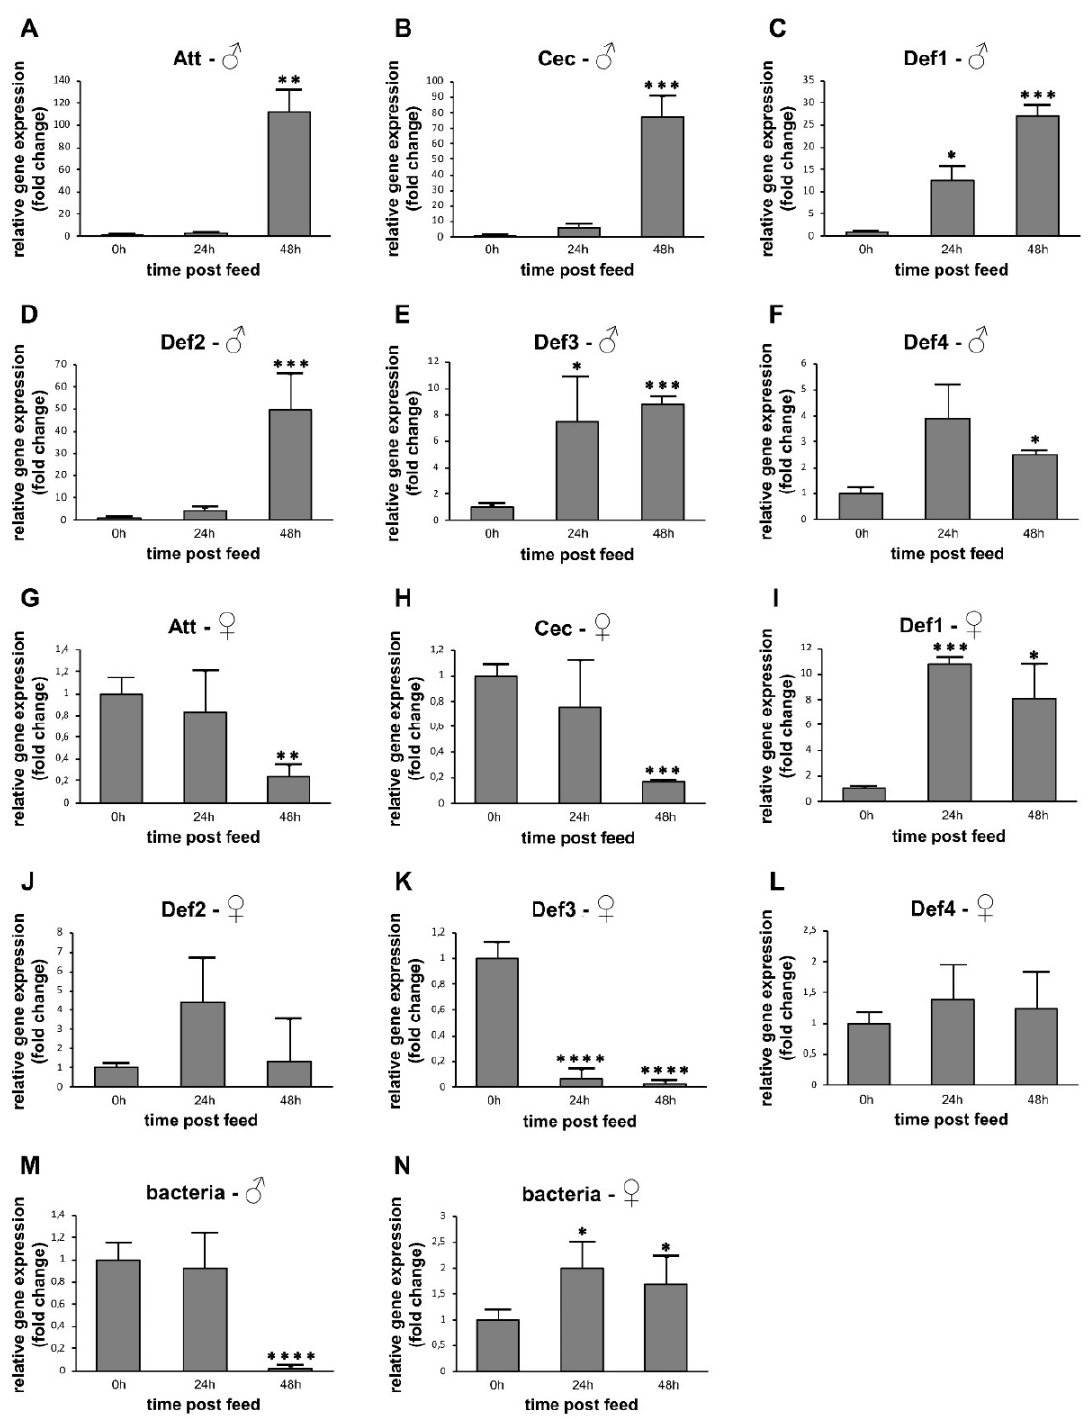
Figure 2. Relative gene expression of AMPs in sugar-fed sand flies. ( A – F , M ) males; ( G – L , N ) females; ( A , G ) attacin; ( B , H ) cecropin; ( C , I ) defensin 1; ( D , J ) defensin 2; ( E , K ) defensin 3; ( F , L ) defensin 4; ( M , N ) bacteria 16S. The y -axis represents relative expression values expressed in comparison to non-fed males or non-fed females. The x -axis represents the feeding stage: non-fed (0 h) or sugar-fed collected at 24 and 48 h post-feeding (PF). Vertical bars represent the average values of three independent experiments, and error bars represent the standard error. Asterisks indicate significant differences (* p < 0.05; ** p < 0.01; *** p < 0.001; **** p < 0.0001).